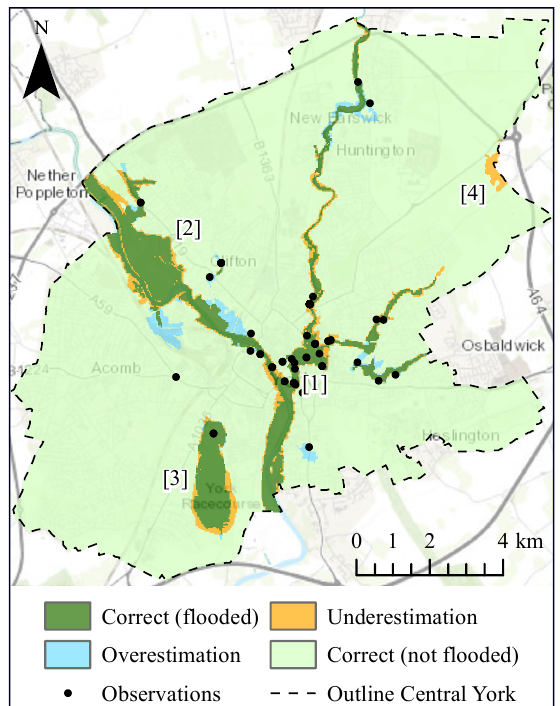
Figure 6. A comparison between the deterministic flood map (mod- elled) and validation data (observed). The locations denoted by the numbers [1] to [4] are referred to in